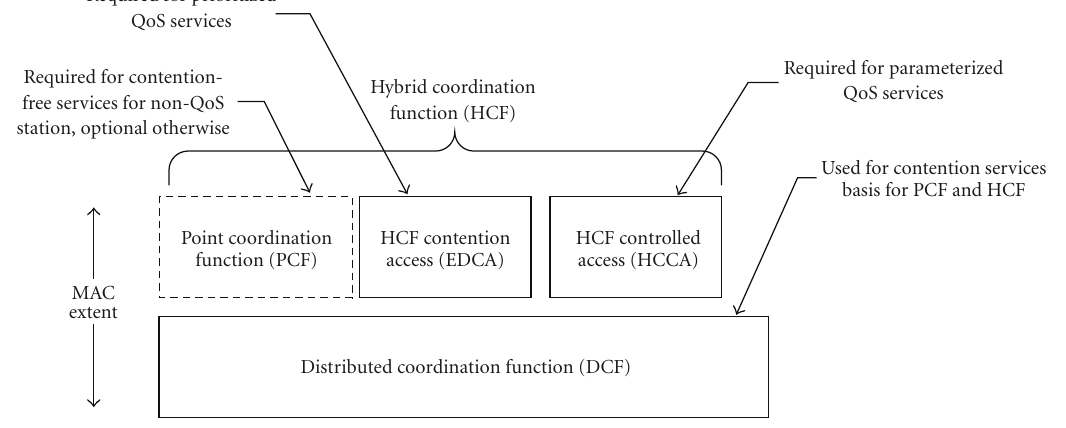
Figure 2: IEEE 802.11e MAC architecture. Table 1: Default DCF and EDCA parameter